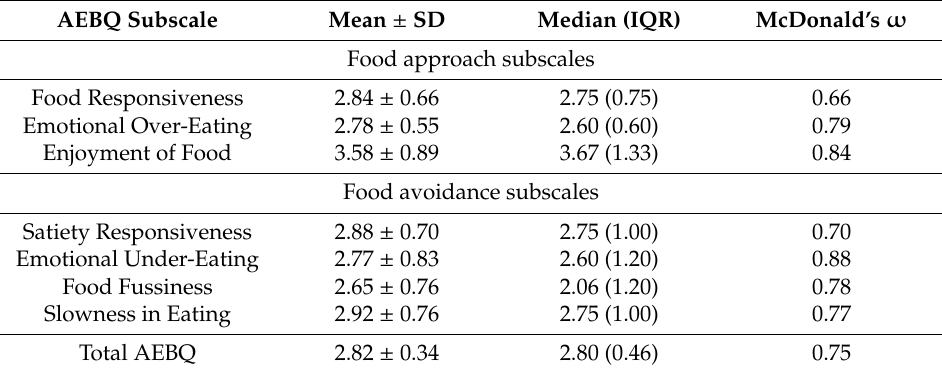
Table 4. Mean and median values and McDonald´s ω reliability scores for each AEBQ subscale in Polish adolescents ( n = 2448).